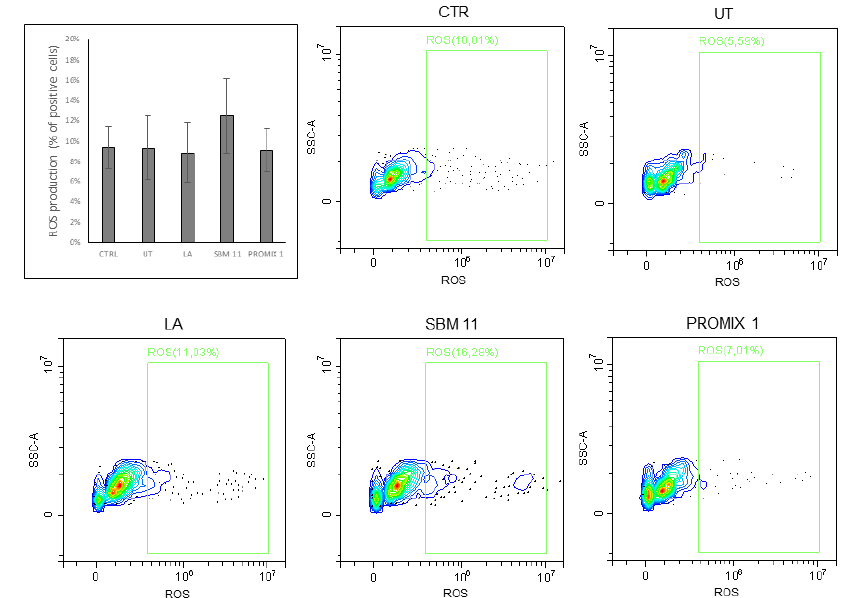
Figure 6. Cytofluorimetric analysis of cell cycle of Namalwa cells after incubation with seaweed extract (UT, LA, SBM-11, PROMIX 1) for 24 h compared with untreated control cells (CTR). Representative images of three independent experiments.